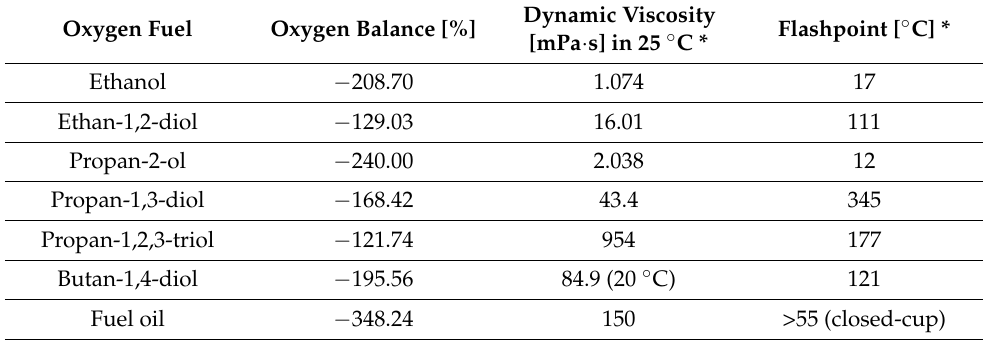
Table 1. Properties of fuels used in research.